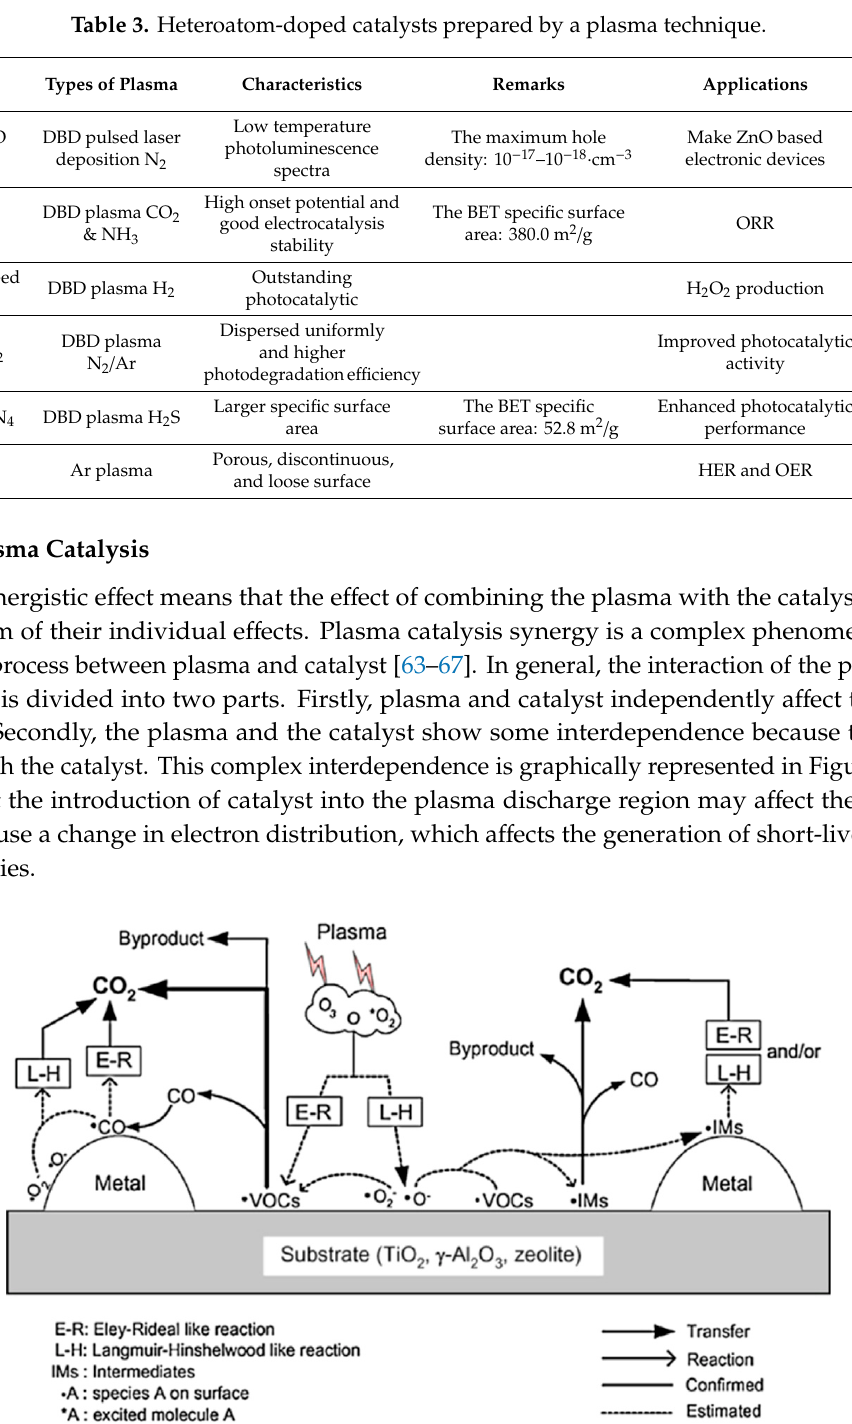
Figure 5. Complex interdependence of plasma–catalyst interactions. Reproduced with permission from [11]; Copyright American Chemical Society, 2015.